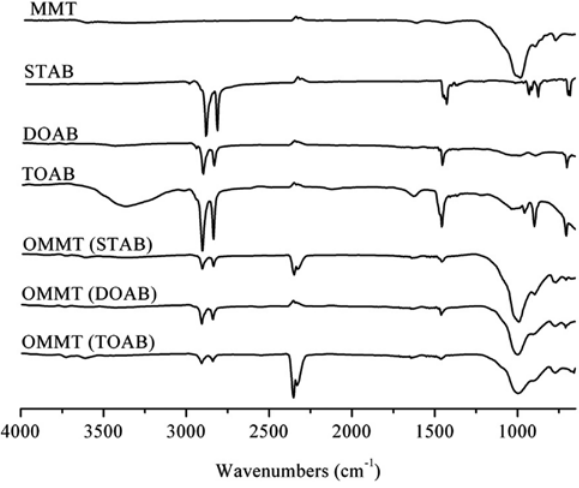
Figure 3 FTIR spectra of MMT, STAB, DOAB, TOAB, and OMMT.